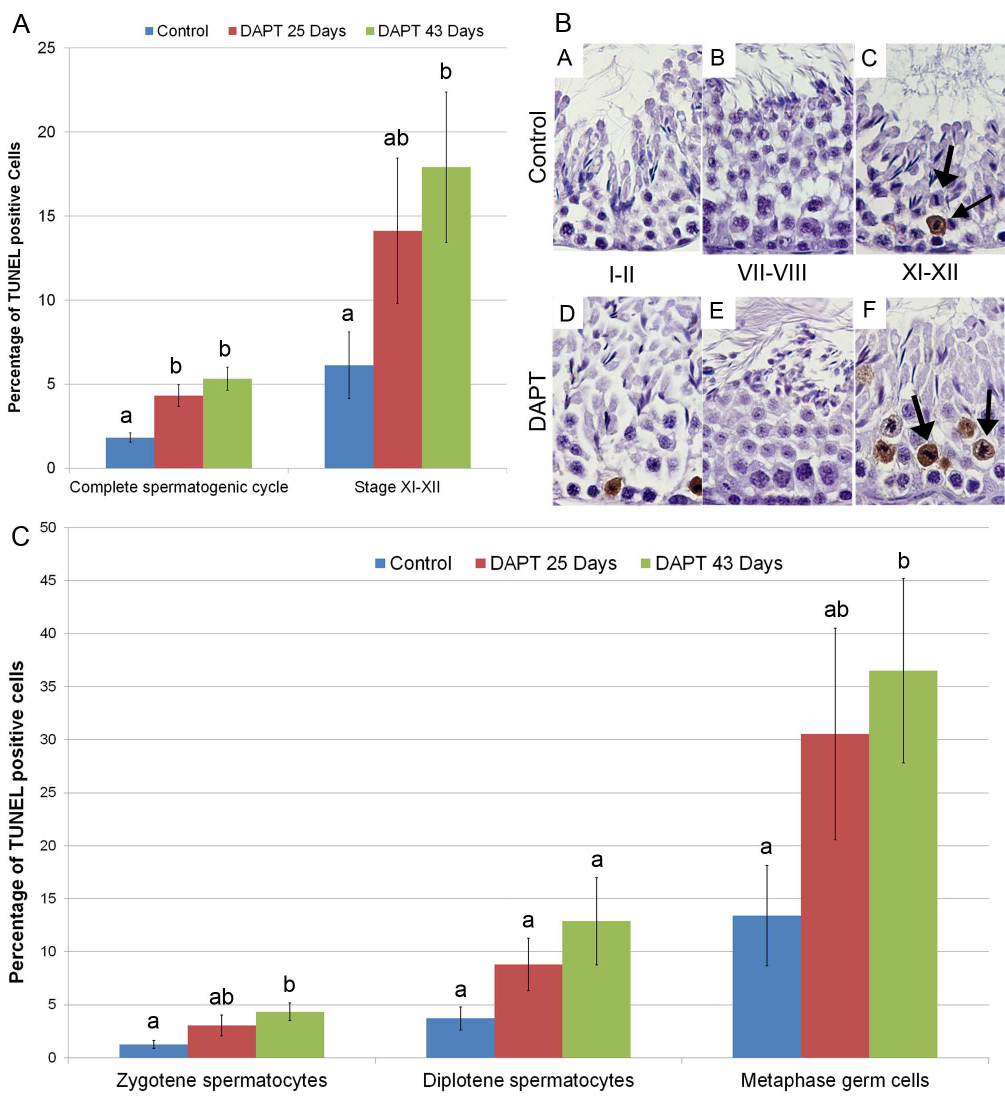
Figure 7. DAPT treatment significantly increases apoptosis during spermatogenesis. A – Relative frequency of apoptotic germ cells at all spermatogenic cycle stages and at stages XI–XII. Error bars represent the standard error of the mean (SEM). Columns with different superscript differ significantly. ab, p , 0.05. B – Apoptosis TUNEL evaluation. TUNEL positive staining in brown, counterstaining with haematoxylin (400x magnification). Arrows mark cells at last steps of meiosis. Apoptosis in seminiferous tubules of control (A–C) and DAPT treated (D–F) mice. Cells at last steps of meiosis are more affected (C, F). C – Relative frequency of apoptotic germ cell types at the most affected spermatogenic stage (XI–XII). Error bars represent the standard error of the mean (SEM). Columns with different superscript differ significantly: ab, p ,